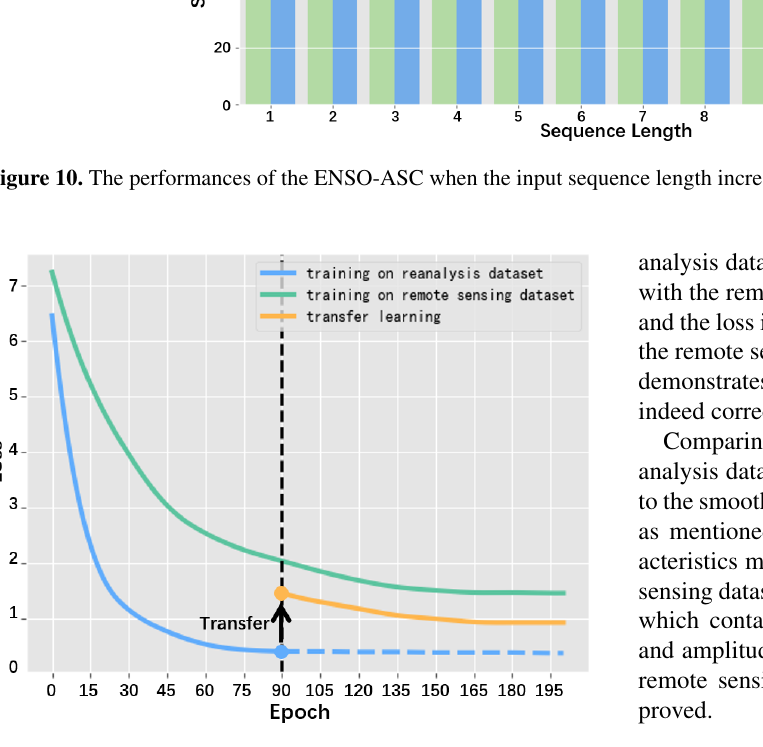
Figure 11. The loss changes when training with only reanalysis dataset (blue line), with only remote sensing dataset (green line) and transfer learning on these two datasets in order (black arrow and yellow line after 90